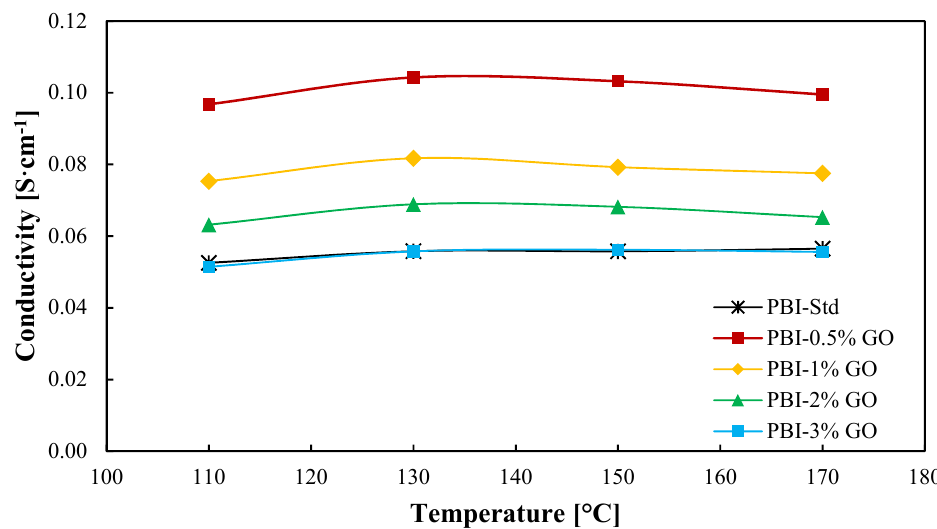
Figure 4. Ionic conductivity as a function of temperature of PBI and GO composite-based PBI membranes. Black line: Standard PBI; Red line: PBI–0.5%GO; Yellow line: PBI–1%GO; Green line: PBI–2%GO; Blue line: PBI–3%GO.